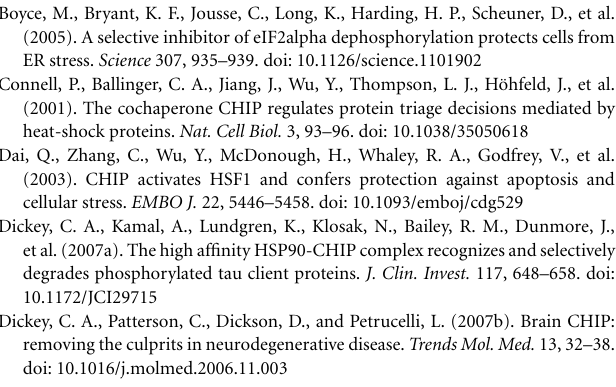
Figure S1 | rAAV8-GFP (B) or rAAV8-CHIP (C) infected slices does not exhibit significant alterations in PI uptake compared to control (A). PI C.I.: 90%, N = 3 independent experiments. Figure S2 | rAAV8-GFP (B) or rAAV8-CHIP (C) infected slices does